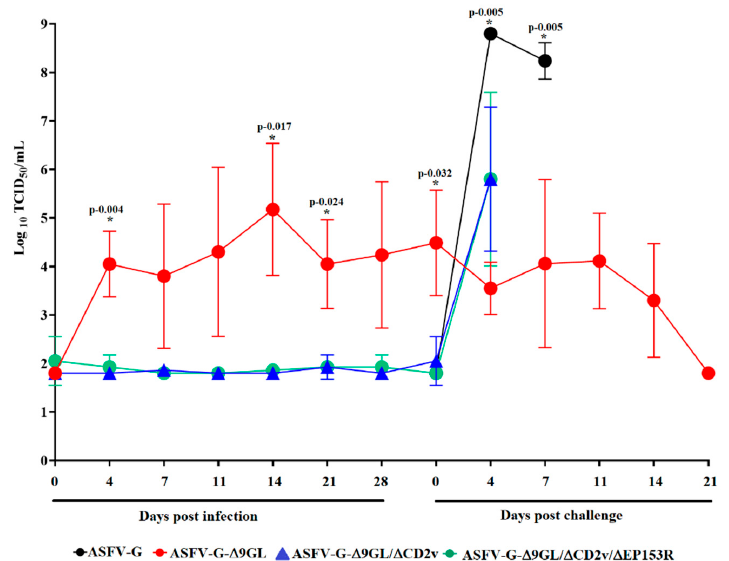
Figure 4. Viremia titers detected in pigs IM inoculated with 10 3 TCID 50 of either ASFV-G- ∆ 9GL, ASFV-G- ∆ 9GL / ∆ CD2v, or ASFV-G- ∆ 9GL / ∆ CD2v / ∆ EP153R. Pre- and post-challenge viremia, presented as average TCID 50 / mL values and their SD are shown per each of the experimental groups. Sensitivity of virus detection: ≥ log 10 1.8 TCID 50 / mL. Statistical significance (*) determined using the Holm–Sidak method ( α = 0.05). Each day of sample collection was analyzed individually, without assuming a consistent SD. Analysis was conducted on Graphpad Prism software version 8.2.1.